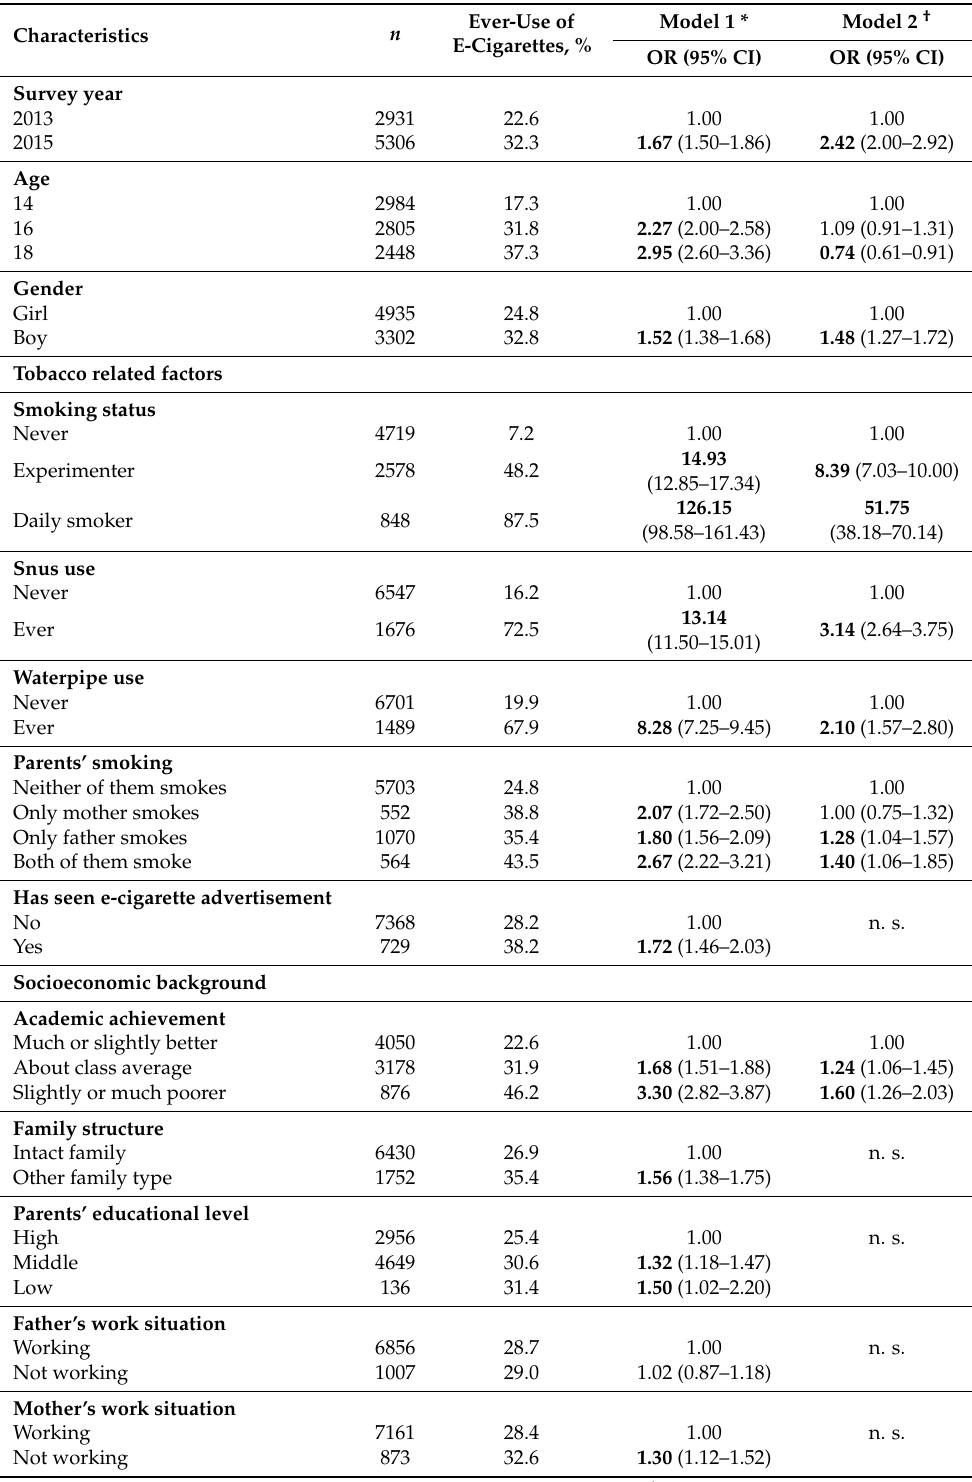
Table 3. Age and gender adjusted prevalence (%) of e-cigarette ever-use and odds ratios (OR) and the 95% confidence interval for e-cigarette use by gender, and tobacco related and socioeconomic factors, among 14–18-year-olds in the pooled data of 2013 and